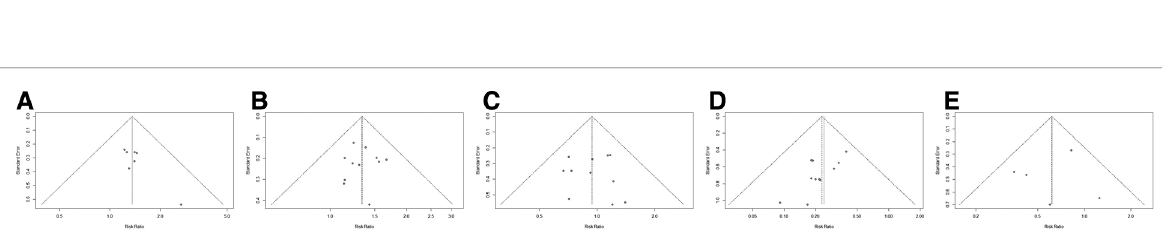
FIGURE 6 Sensitivity analysis plot of treatment effect rates. According to the leave-one-out method sensitivity analysis, the individual study results had no impact on the meta-analysis results in all four rates. ( A ) cure rate; ( B ) remarkable effect rate; ( C ) effective rate; ( D ) invalid rate.